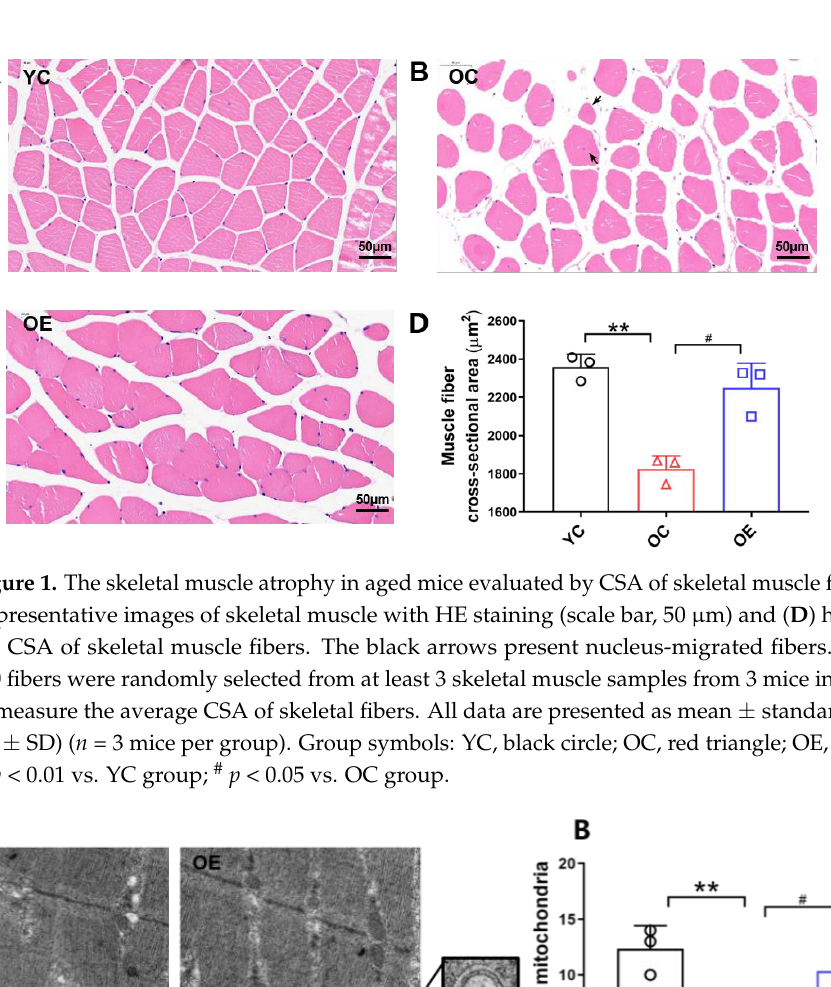
Figure 2. Lifelong aerobic exercise repaired the damaged mitochondria in skeletal muscle fibers during the aging process. ( A ) Representative images of gastrocnemius muscles of the mice from each group (8000×) observed by TEM; white arrows: mitochondria; black arrows: autophagosomes. ( B ) The number of mitochondria was counted from randomly selected images of 3 skeletal muscle samples from each group. All data are presented as mean ± standard deviation (M ± SD) ( n = 3 mice